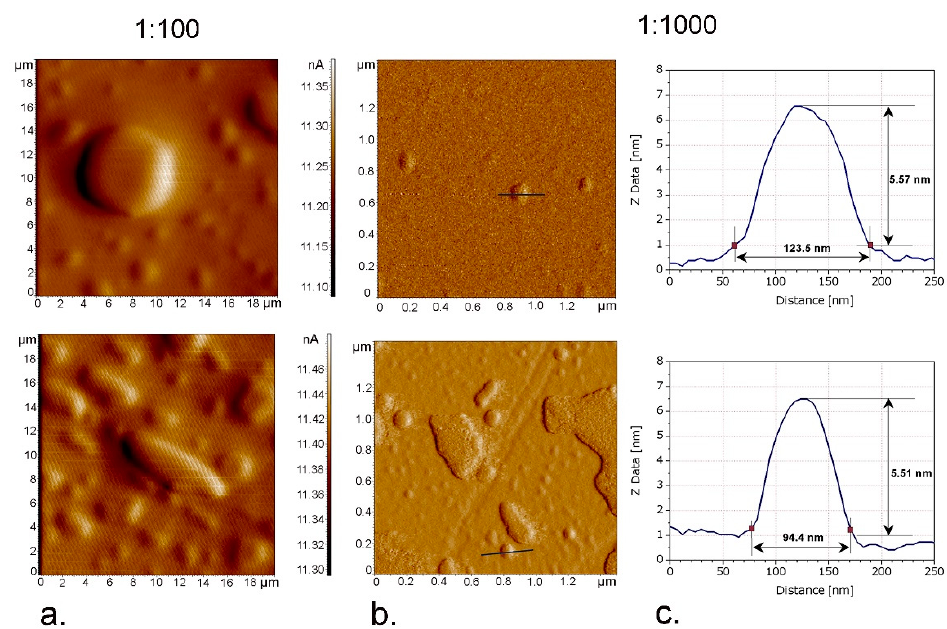
Figure 4. Atomic force microscopy (AFM) of the selected nanoemulsion samples F1 (upper row) and F2 (lower row) at different dilutions: ( a ) 2D “error signal” of 20 × 20 µ m 2 of the samples at 1:100 dilution ( b ) 2D “error signal” of 2 × 2 µ m 2 of the samples at 1:1000 dilution with marked droplet profile; ( c ) height profiles of the two selected nanoemulsion droplets at 1:1000 dilution.